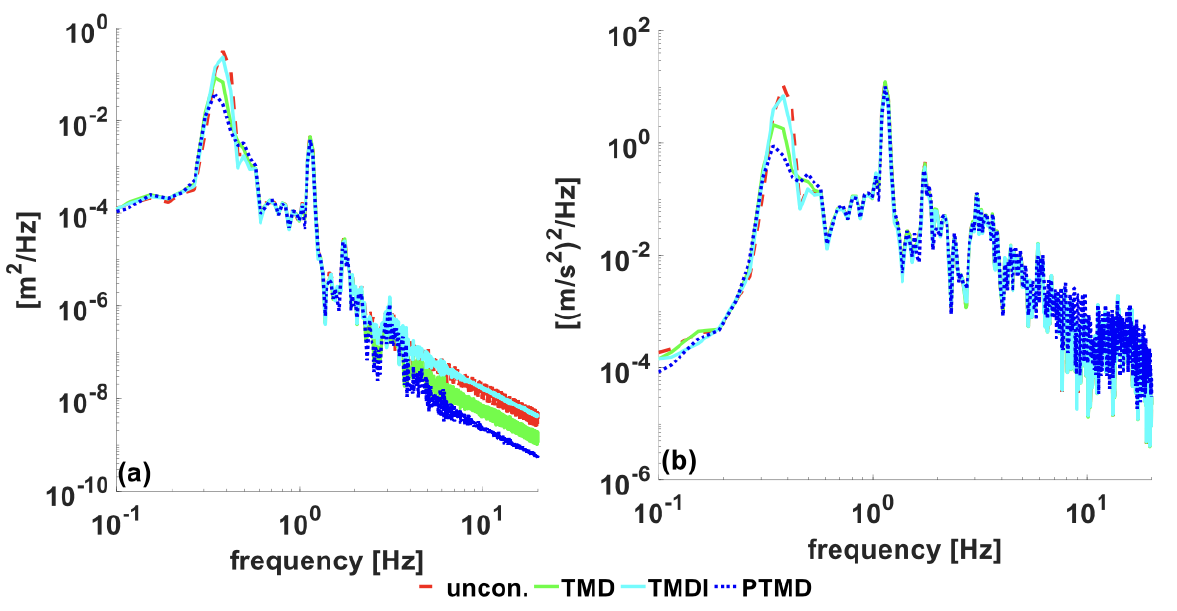
Figure 17. Response spectra of the 42nd story under El-Centro earthquake: ( a ) displacement and ( b ) acceleration.